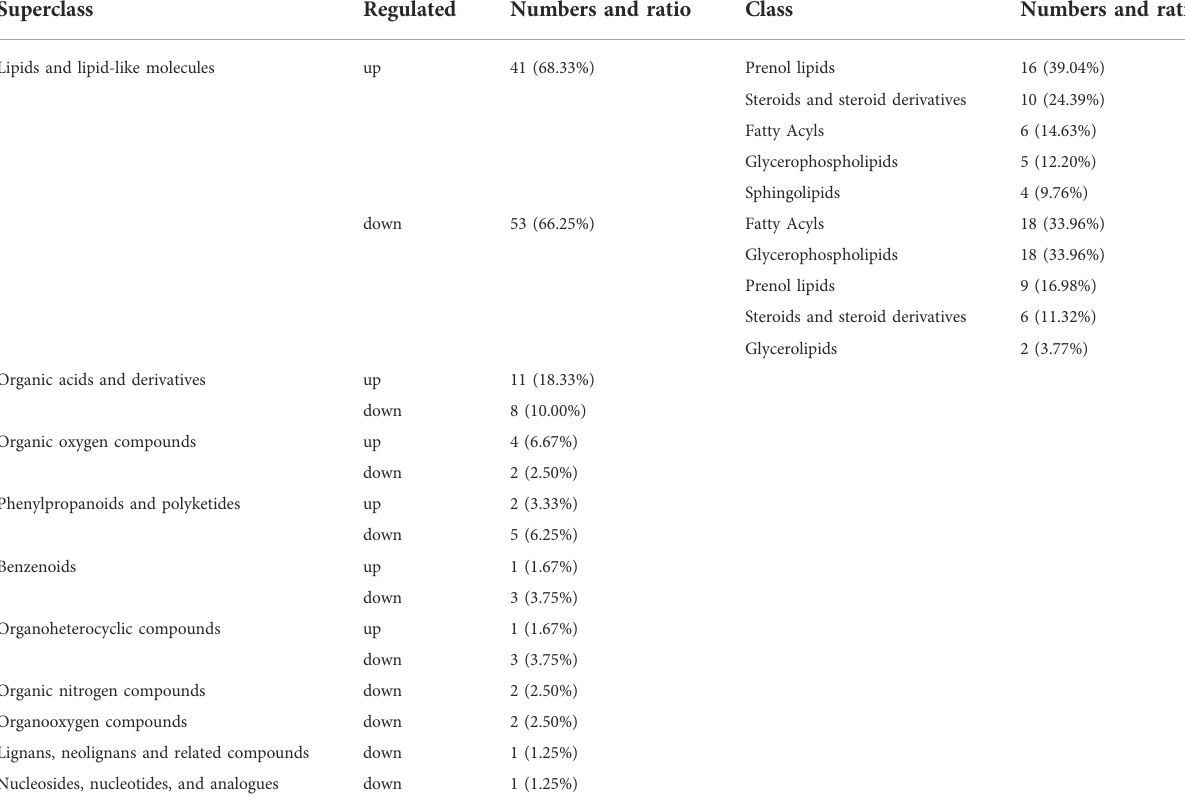
TABLE 5 Classi fi cation of HMDB compounds for differential metabolites at superclass and class levels.